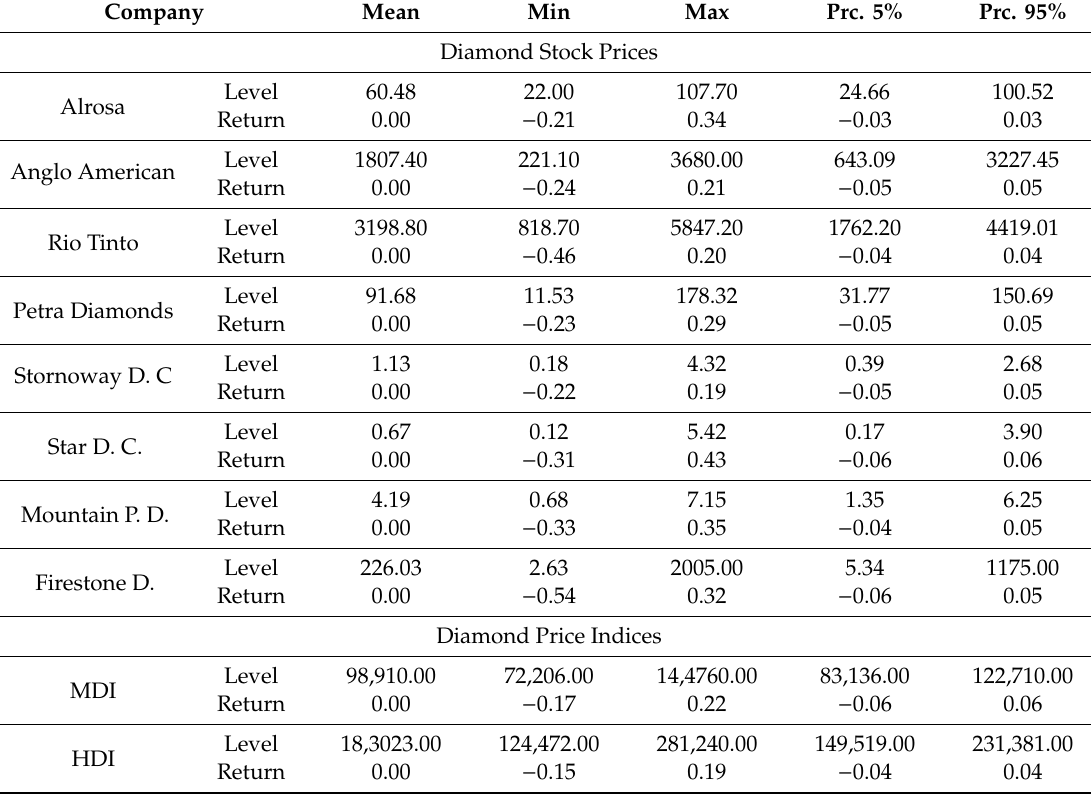
Table 3. Summary statistics for diamond stocks and diamond indices in levels (original currencies). Company